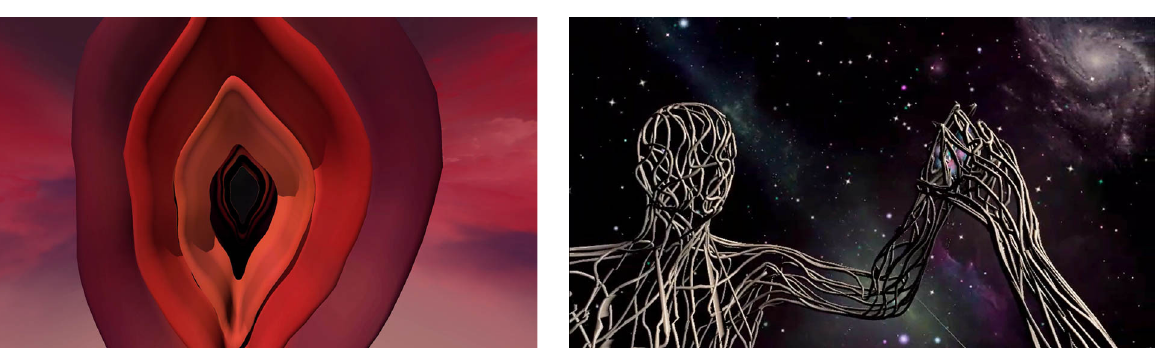
Figure 5: Screenshot of Intro VMSE progression into vulva - like tunnel taken from Oculus Quest. ( Figure 5 ) . Its contractions were synchronized to the beat.